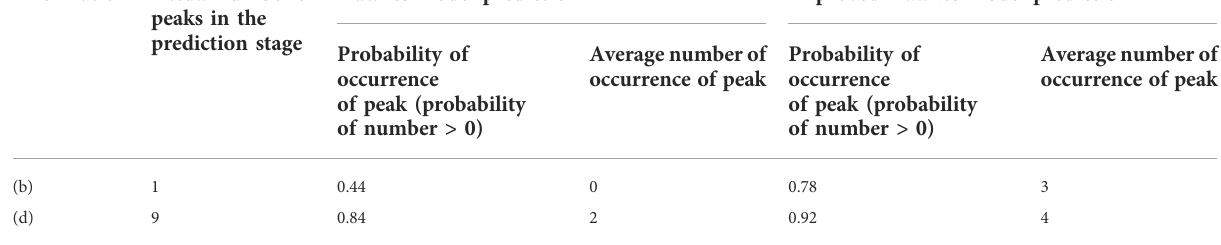
TABLE 3 Predicted peaks of the propagation